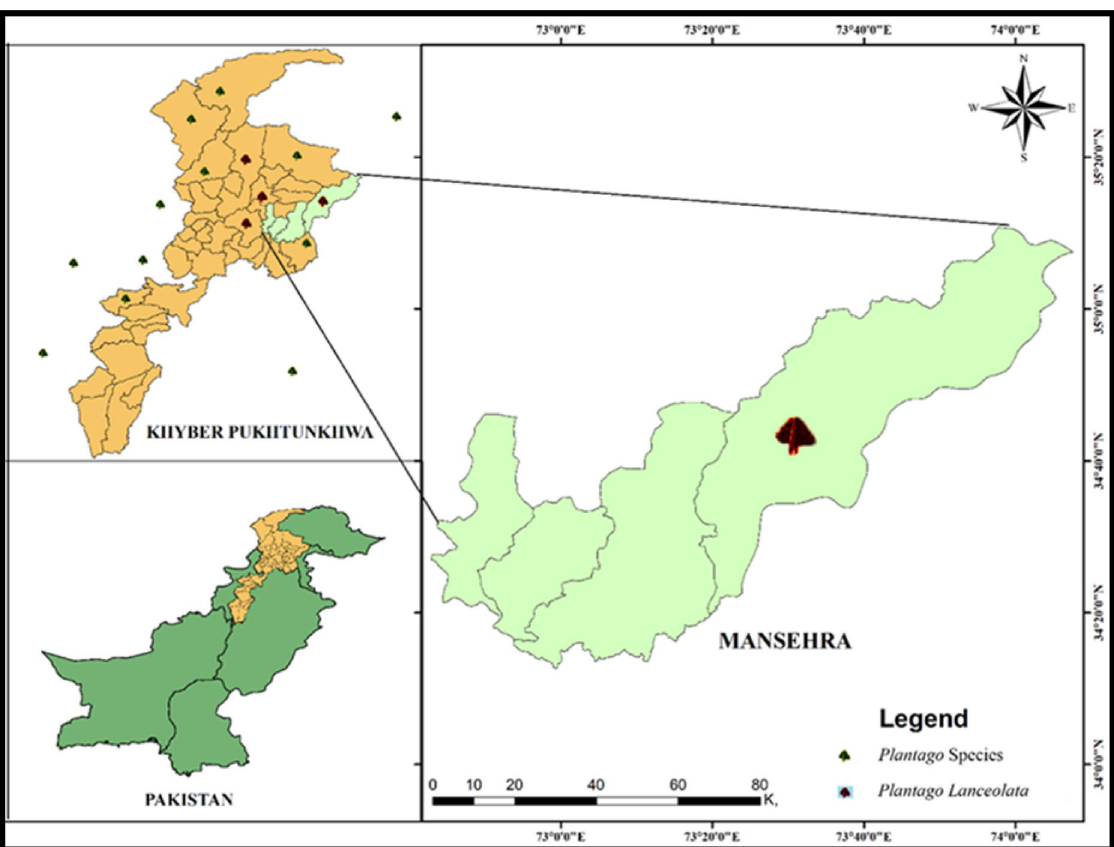
Figure 1. Plantago species and Plantago lanceolata distribution and collection points map. This map is generated using ArcGis 10.1.2 software. The shape files of the study area (Pakistan, Khyber Pakhtunkhwa, Mansehra) was generated in ArcGis software and then digitized using the location points of the plant species. The official links for this software are:https:// www. esri. com/ en- us/ arcgis/ produ cts/ arcgis- platf orm/ overv